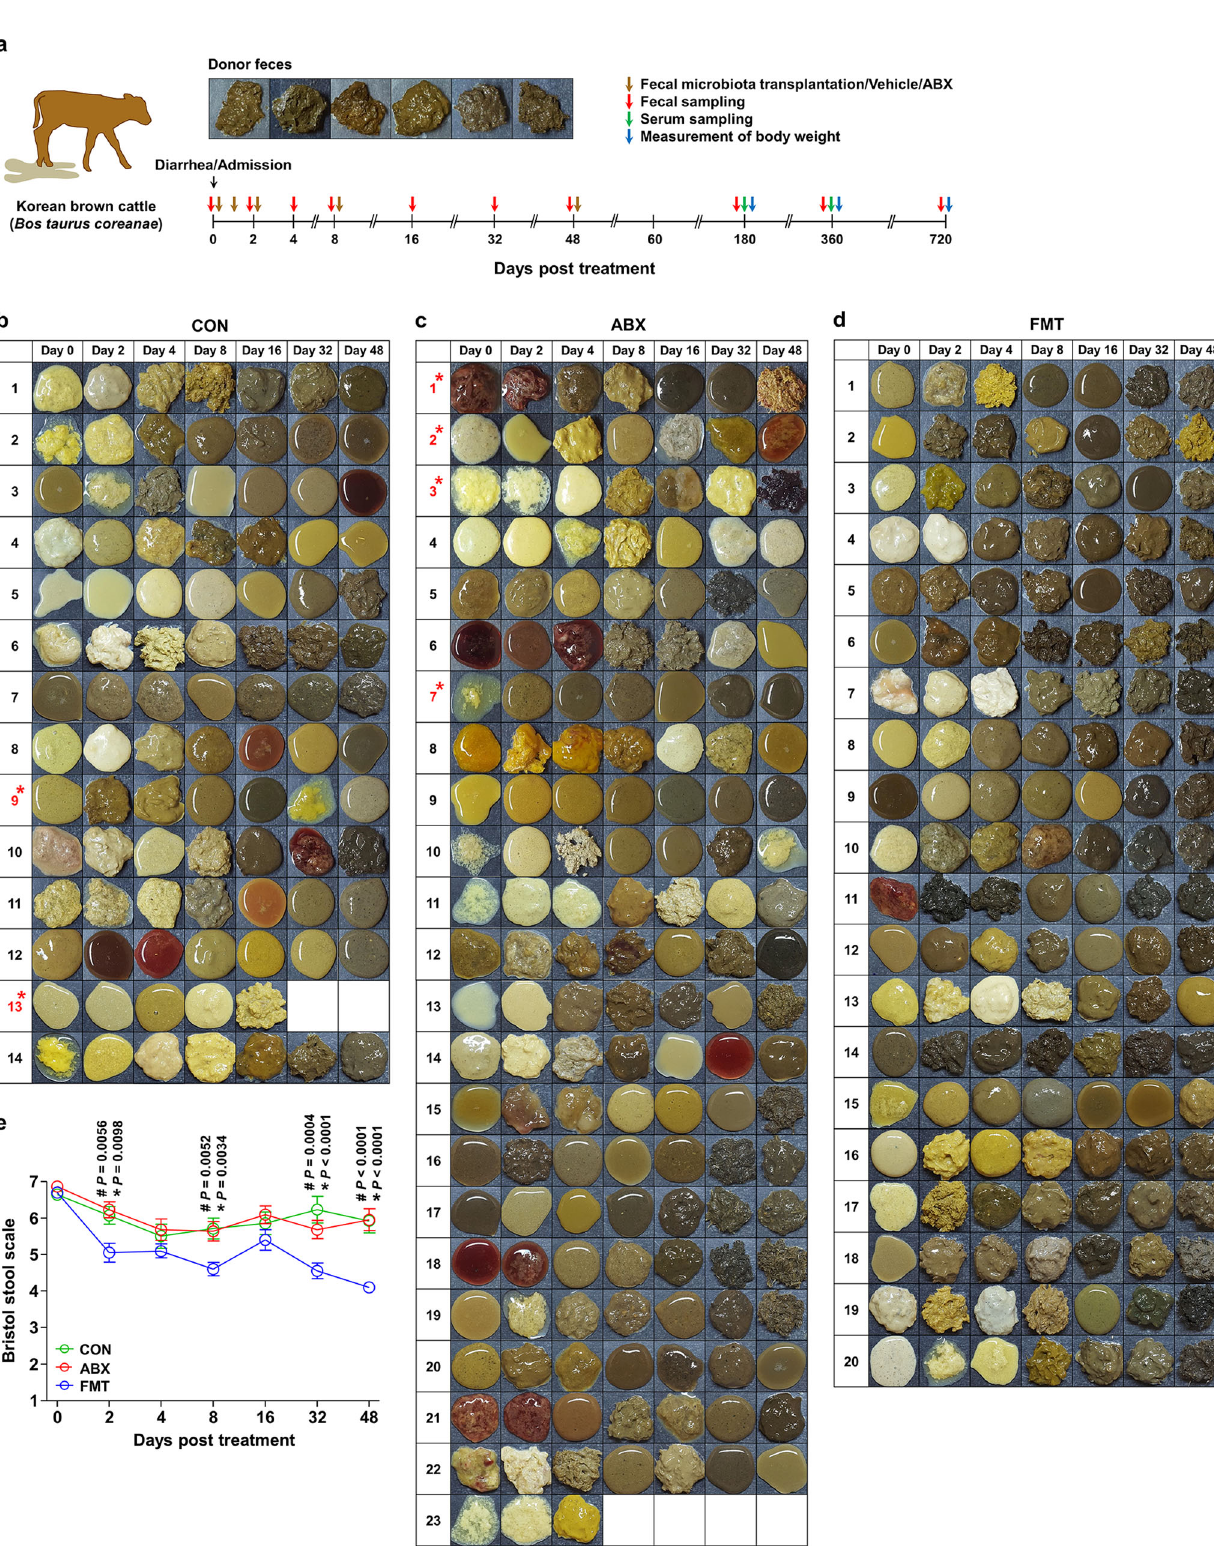
NATURE COMMUNICATIONS| (2021) 12:161